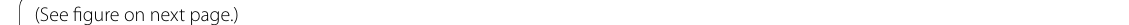
figure on next Fig. 3 Correlations between weight gain and ASVs. Legend: Spearman rank correlation plot showing significant correlations ( P < 0.05, FDR corrected) between change in percent relative abundance and percent relative weight gain between time points (D21-D24, D24-D28 and D28-D35). Red circles indicate negative and blue circles indicate positive correlations. The size of the circle indicates the strength of the correlation. Neighbor-joining tree with bootstrap values (bootstrap 100, values < 50 not shown) based on MUSCLE alignment of 16S rRNA v4 gene region = depict phylogenetic relationship between